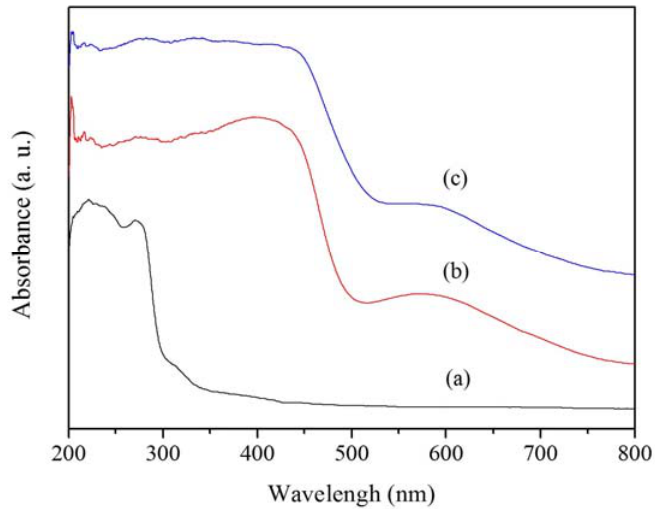
Figure 2. UV-vis spectra of ( a ) CuMgAl-LDH; ( b ) Cr(SO 3 -salen); ( c ) Cr(SO 3 -salen)-CuMgAl-LDH. As detected by the powder XRD (see Figure 3), all LDH carriers and the LDH-hosted